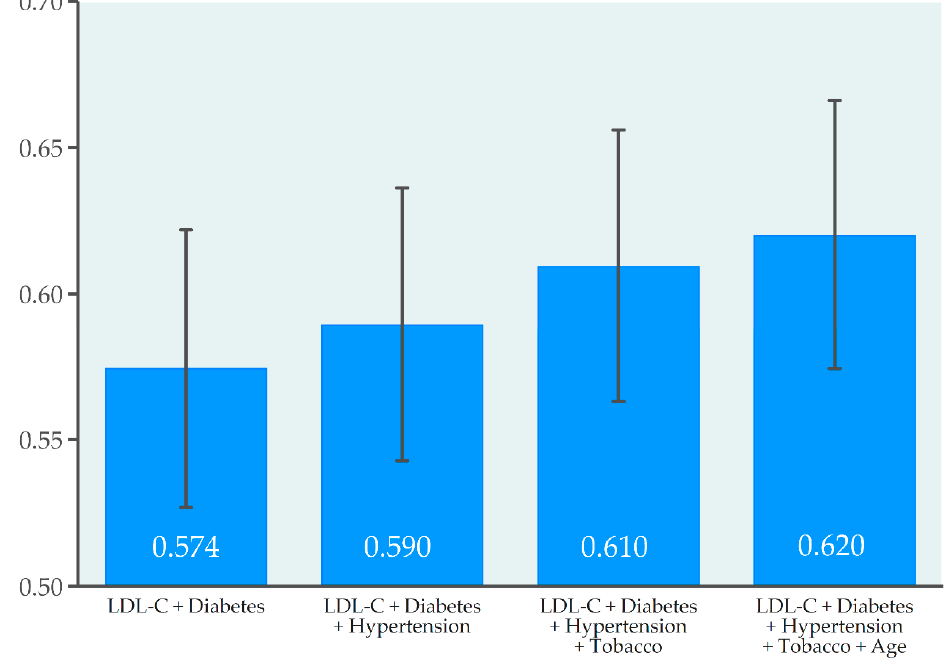
Figure 2. Prescribing of high-intensity statins: predictive capacity of clinical and analytical variables. Data are represented as the area under the receiver operating characteristic (ROC) curve and 95% confidence intervals (error bars). Abbreviation: LDL-C, low-density lipoprotein cholesterol.